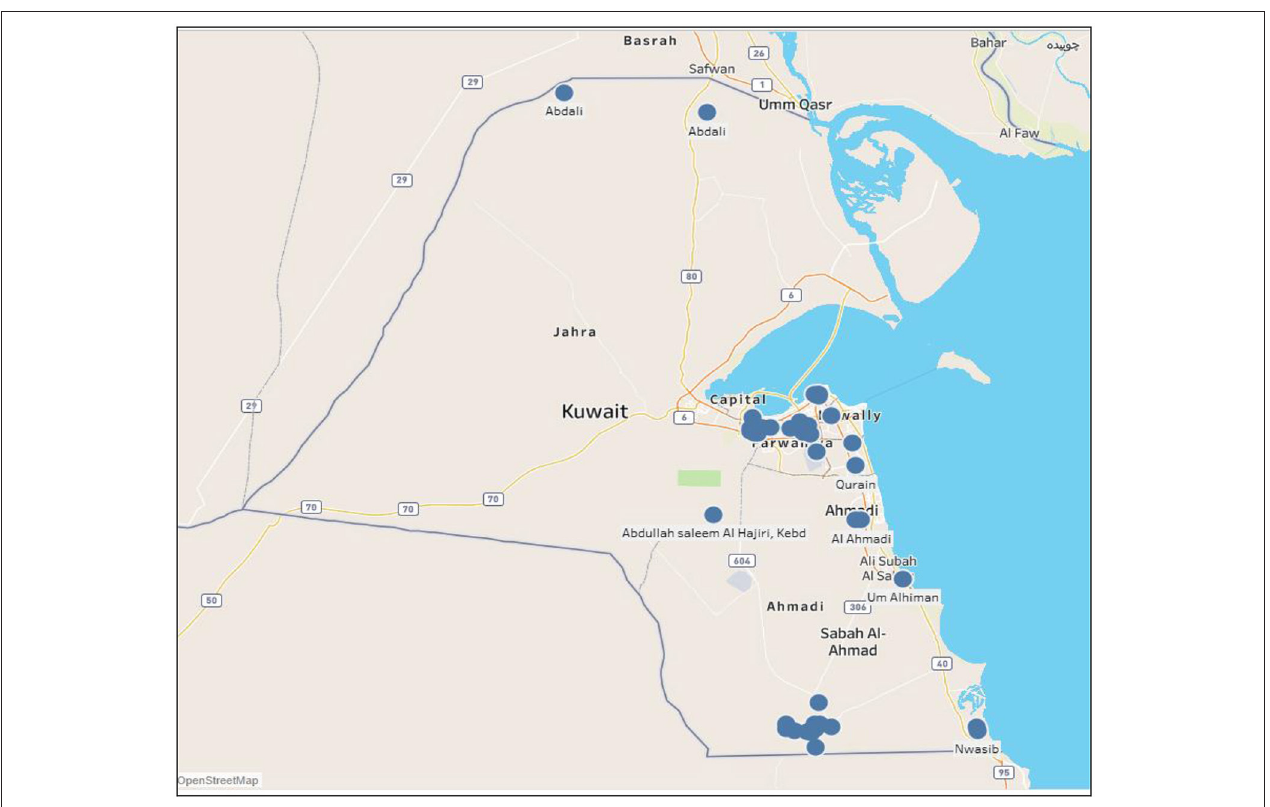
FIGURE 1 | Spatial distribution of all animal diseases in Kuwait (2005–2020). Circles indicate the location of farms with